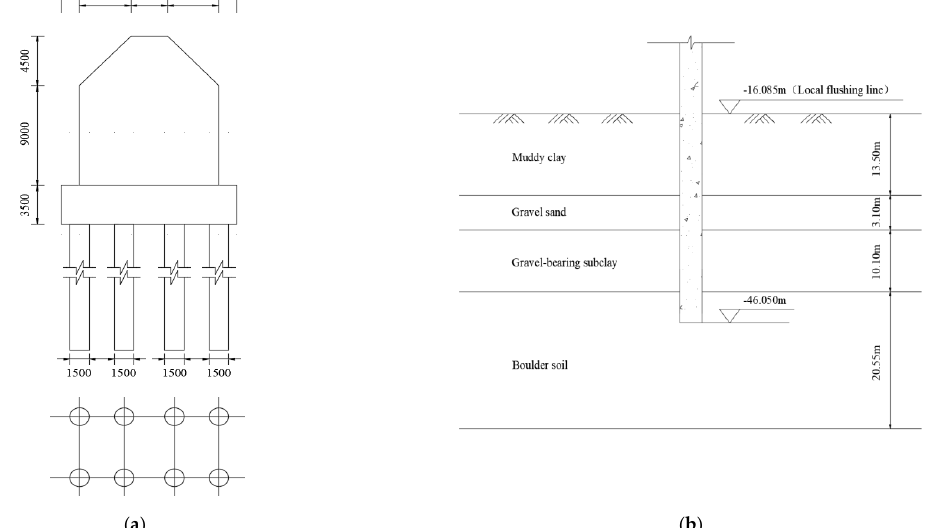
Figure 5. Bridge foundation and soil layer: ( a ) arrangement of the pile-group foundation; ( b ) geological conditions around the pile.